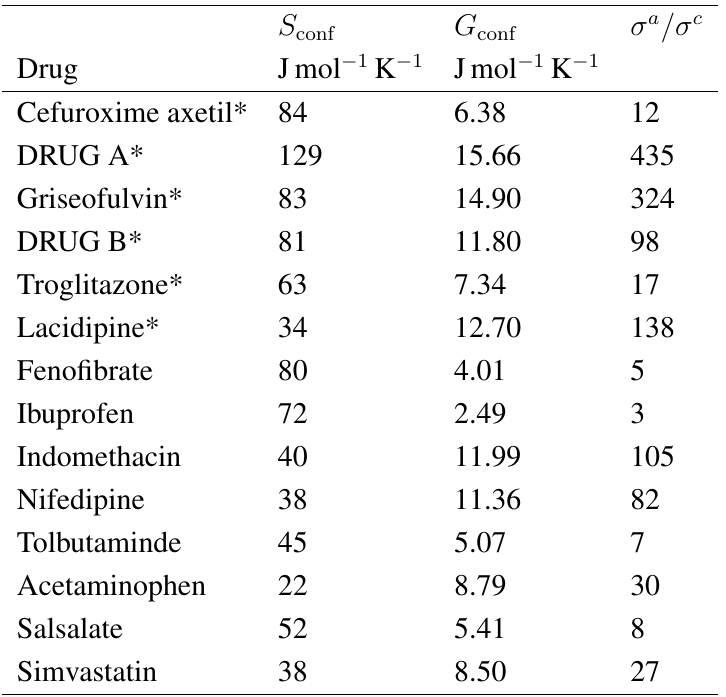
Table 3. S , G and calculated solubility ratio between amorphous and conf conf crystalline drugs (* values obtained from non-equilibrium